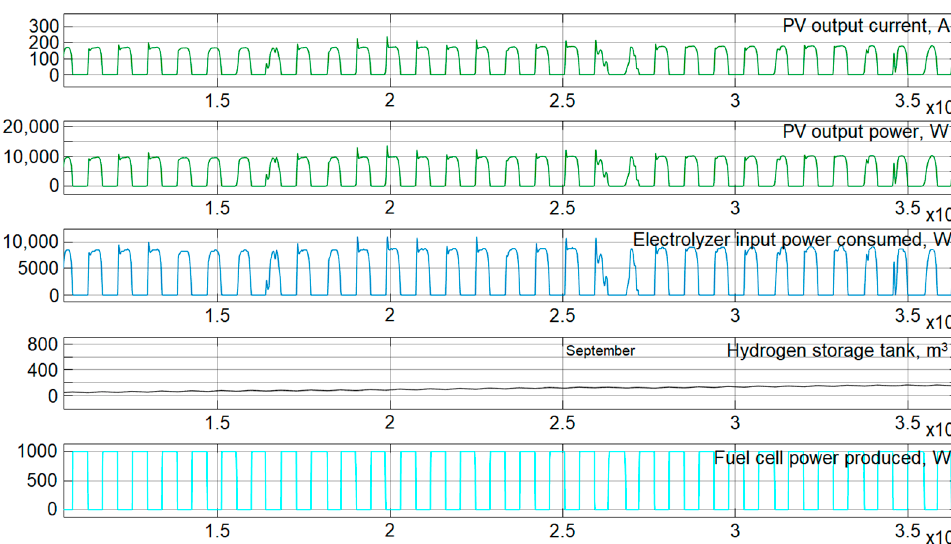
Figure 22. The result of the simulation and calculation of the required hydrogen tank capacity for the location Gnaraloo, Australia (April only).